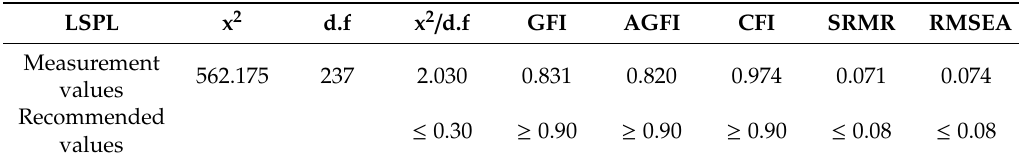
Table 16. Results of fit indices for CFA.